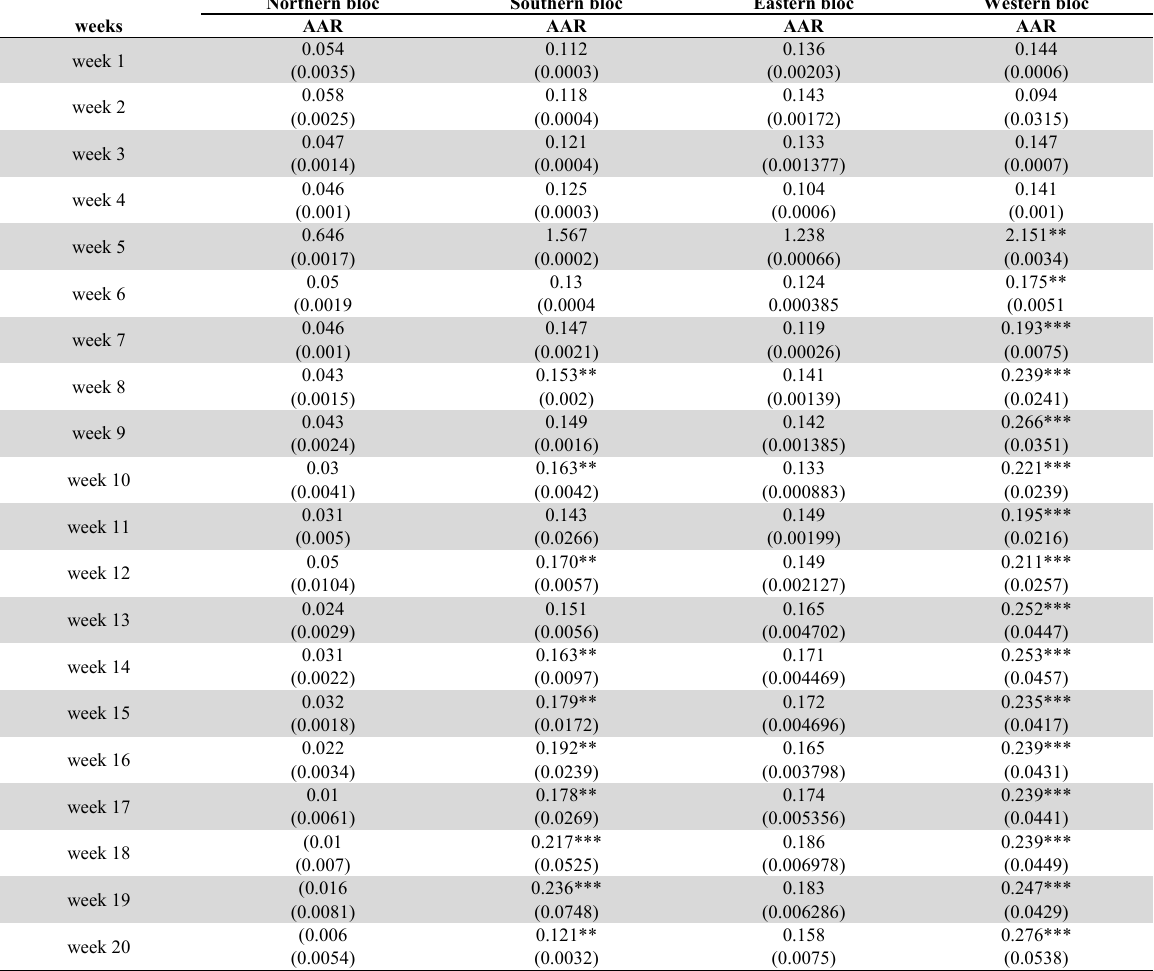
Table 10 AARs for the regional blocs 20 weeks after the event of 1st COVID-19